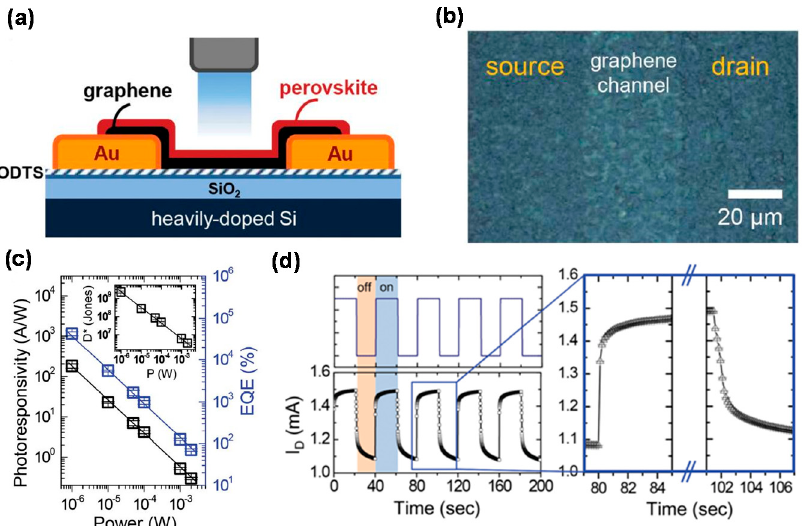
Figure 7. ( a ) Schematic diagram of the perovskite-graphene hybrid PD; ( b ) Optical microscopy image of the CH 3 NH 3 PbI 3 -graphene PD; ( c ) Photoresponsivity and EQE vs. illumination power. The inset shows the photodetectivity ( D* ) vs. illumination power; ( d ) On-off switching characteristics of the PD under dark and light illumination. By the pulsed laser illumination (left top), the temporal response of the photocurrent is shown (left bottom). Reproduced with permission for Figure 7a − d from 2014 Advanced Materials [74].